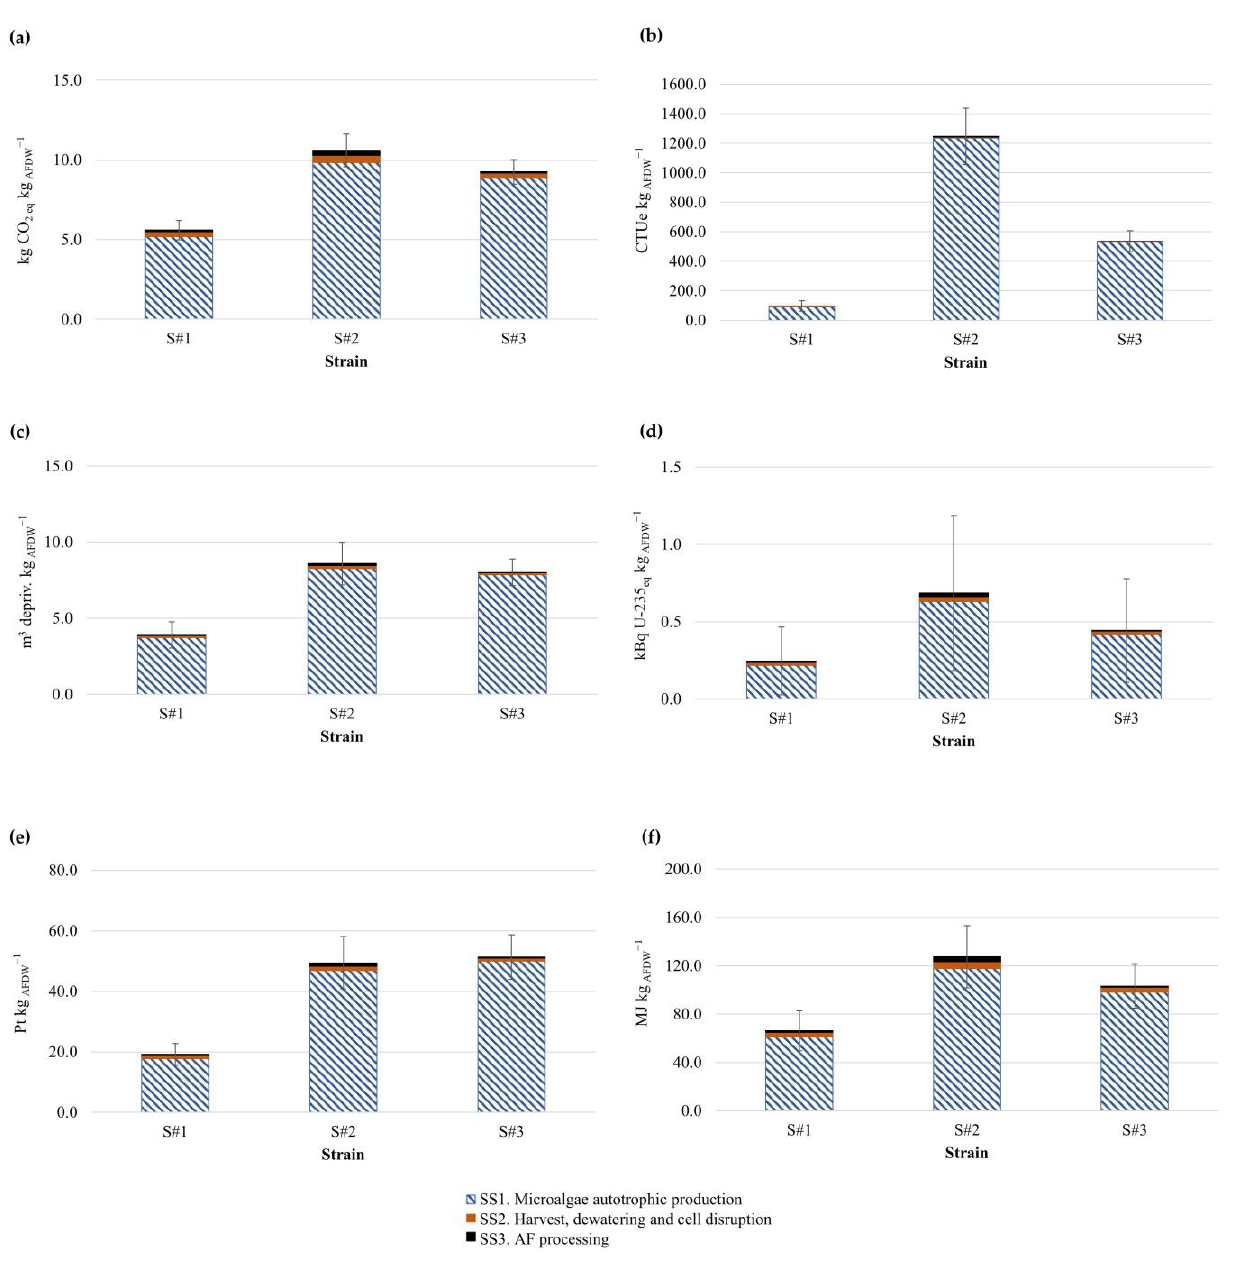
Figure 4. Environmental impact comparison between the three produced microalgal strains (S#1, S#2, and S#3) for selected environmental categories in Scenario 4: ( a ) climate change; ( b ) freshwater toxicity; ( c ) water use; ( d ) ionizing radiation; ( e ) land use; ( f ) fossil resource use. Uncertainty values for the characterized LCIA profiles for each strain (the error bars represent the uncertainty based on confidence intervals of 95%).